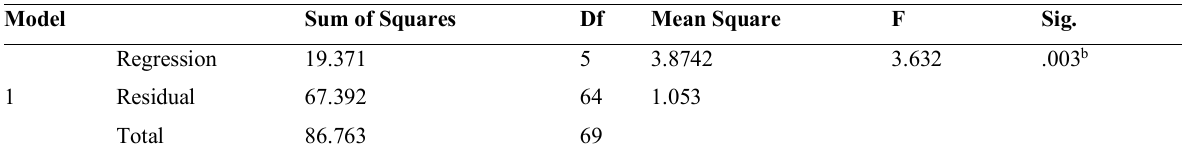
Table 4: ANOVA for Loan Pricing